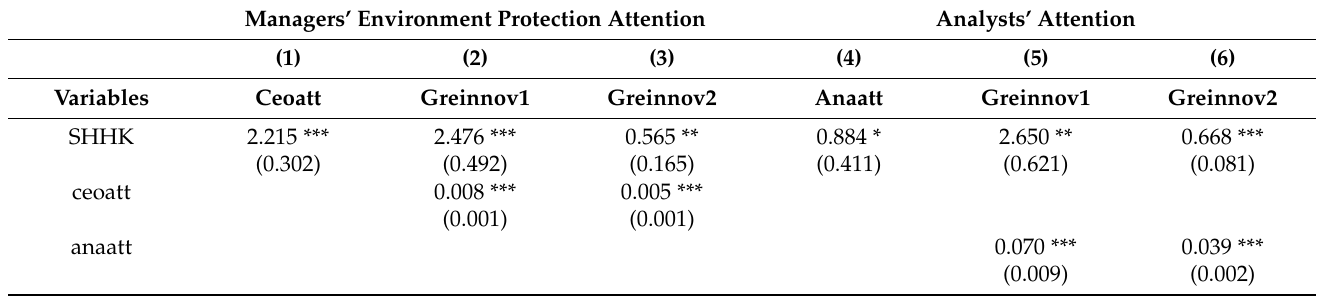
Table 3. Regression results of mechanism